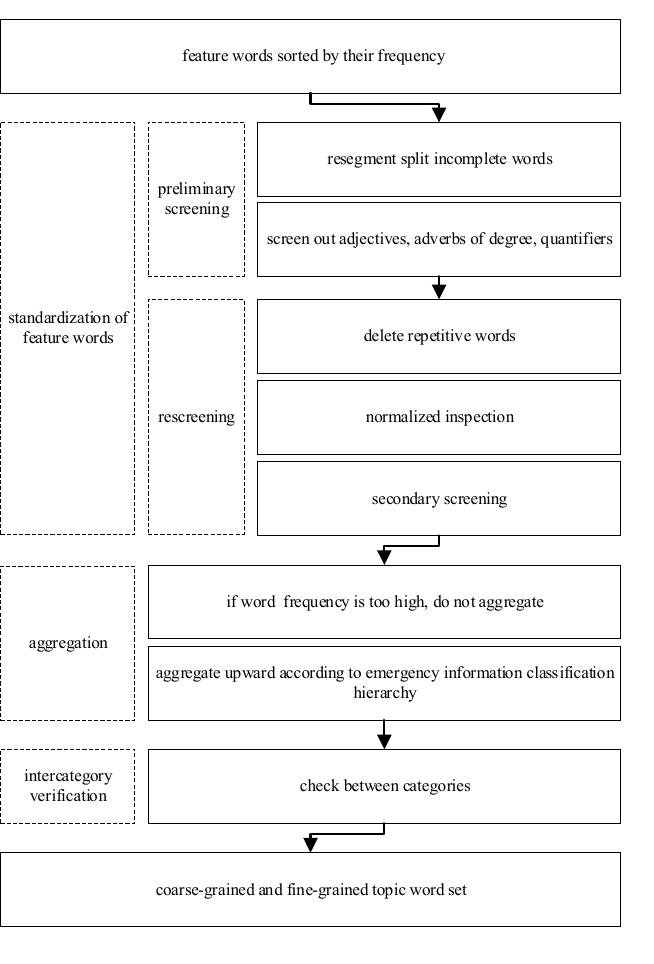
Figure 3. Data process used to detect the topic-words.